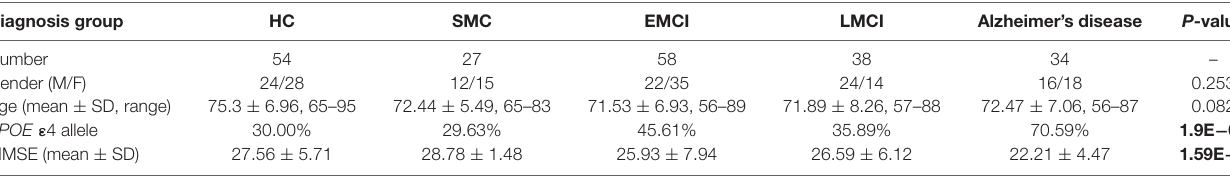
TABLE 1 | Human subject